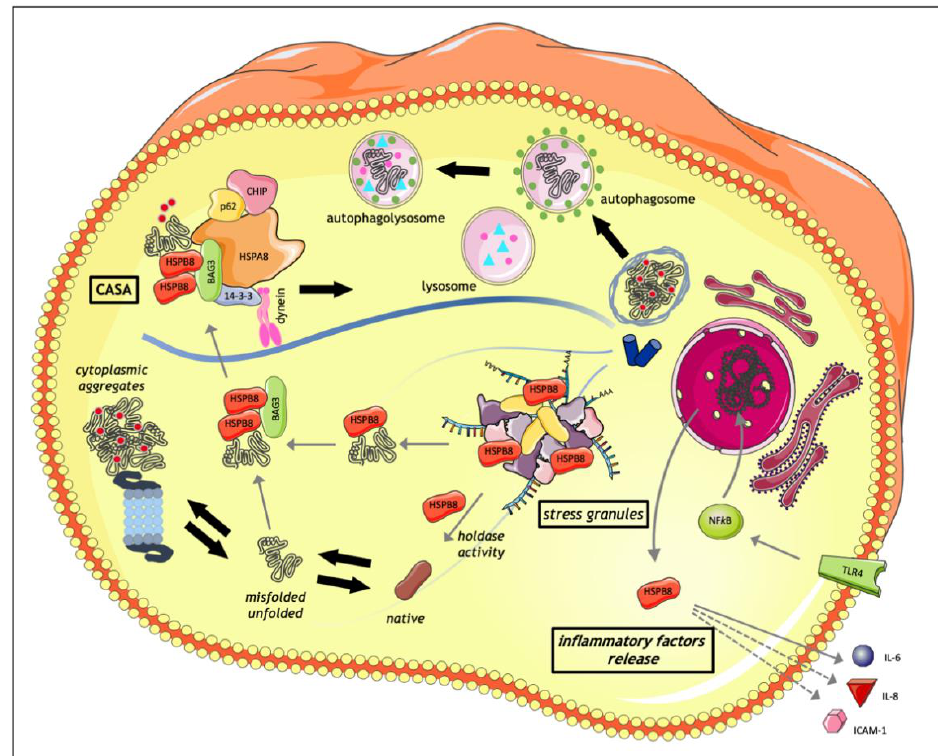
Figure 2. Schematic representation of HSPB8 activities in the interphase. HSPB8 is mainly involved in the maintenance of intracellular proteostasis, being an important component of the protein quality control system (PQC). In this context, HSPB8, together with its partner BAG3, HSPA8, and the STUB1/CHIP proteins, forms the chaperone-assisted selective autophagy (CASA) complex, which assists the degradation of aberrantly folded substrates via autophagy. The CASA complex is able to recognize and bind several misfolded proteins and it drives them along microtubules to the microtubule organization center (MTOC) for their insertion into autophagosome and subsequent lysosomal degradation. Moreover, HSPB8 is directly involved in the maintenance of stress granule (SG) dynamism: in fact, in stress conditions, HSPB8 is upregulated and it is specifically recruited to SGs where it both assists the folding of defective ribosomal products (DRiPs) (holdase activity) and promotes the extraction of misfolded substrates from SGs, for their following BAG3-HSPA-mediated degradation. Another role of HSPB8 is in the inflammatory response. HSPB8 can induce the release of inflammatory factors (IL-6, IL-8, ICAM1) from human smooth muscle cells and brain pericytes and astrocytes in models of cerebral amyloid angiopathy. It is also involved in TLR4-mediated dendritic cell maturation and activation accompanied by IL-6 production. This figure was created using Servier Medical Art templates, which are licensed under a Creative Commons Attribution 3.0 Unported License; https://smart.servier.com (accessed on 27 January